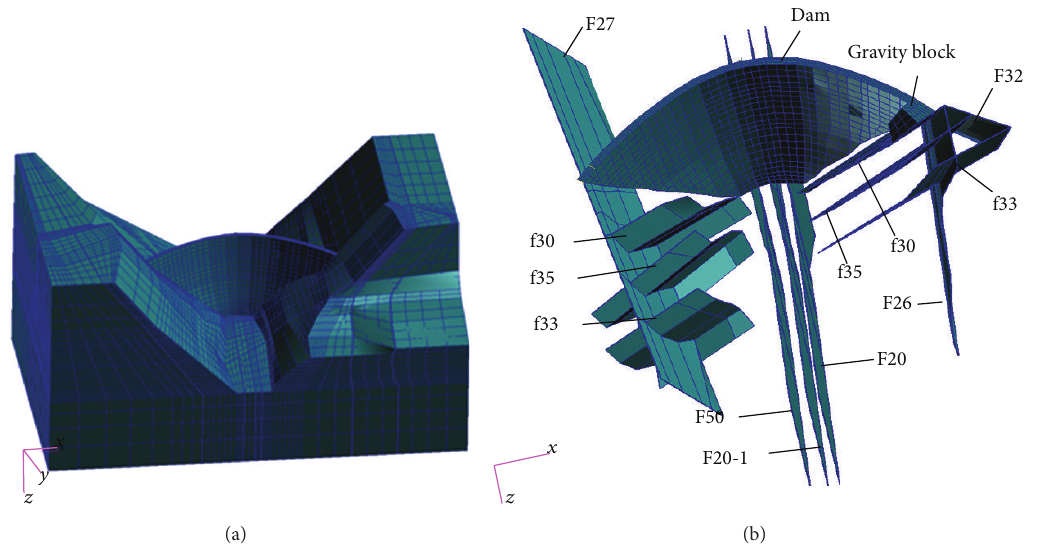
Figure 4: 3D FEM mesh model of Lijiaxia arch dam: (a) 3D overall mesh model; (b) main faults distribution.